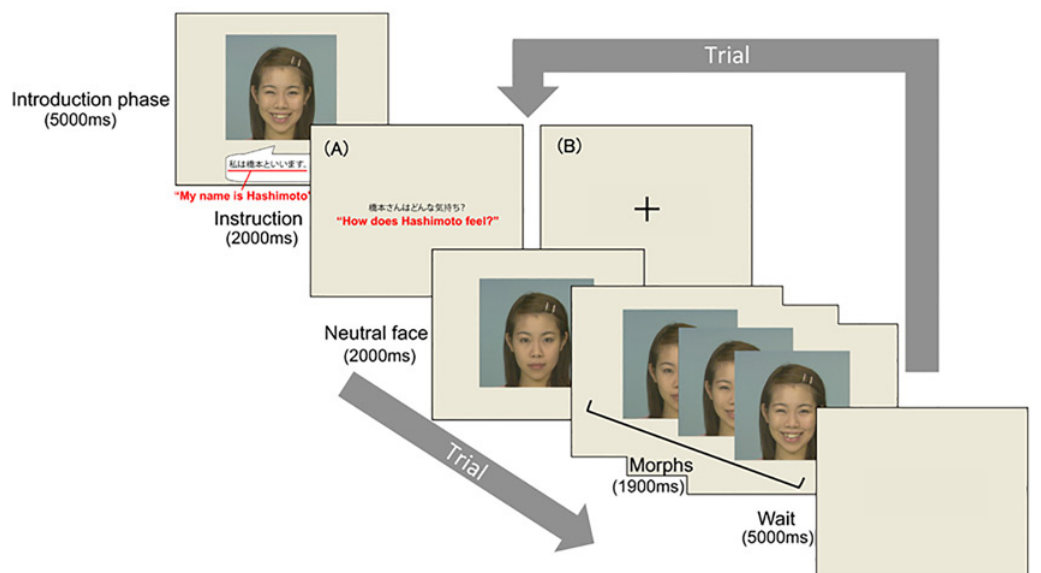
Fig 2. Task flow in Study 1. At the beginning of each block, an introduction-picture was presented, followed by 2 – 4 trials. (A) In the Emotion-Inference condition, the instruction “ How does XXX (e.g., Hashimoto) feel? ” was presented in Japanese. (B) In the Passive (control) condition, a fixation cross was presented. Reprinted from the ATR Facial Expression Image Database DB99 under a CC BY license, with permission from ATR-Promotions Inc., original copyright (2006).